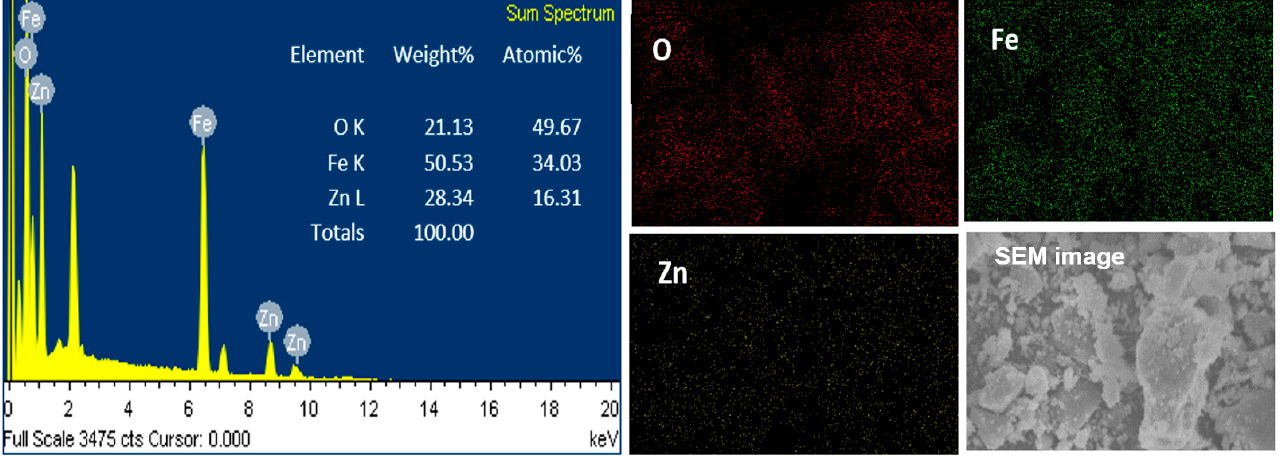
Figure 5. EDS of ZFNPs and elemental mapping.